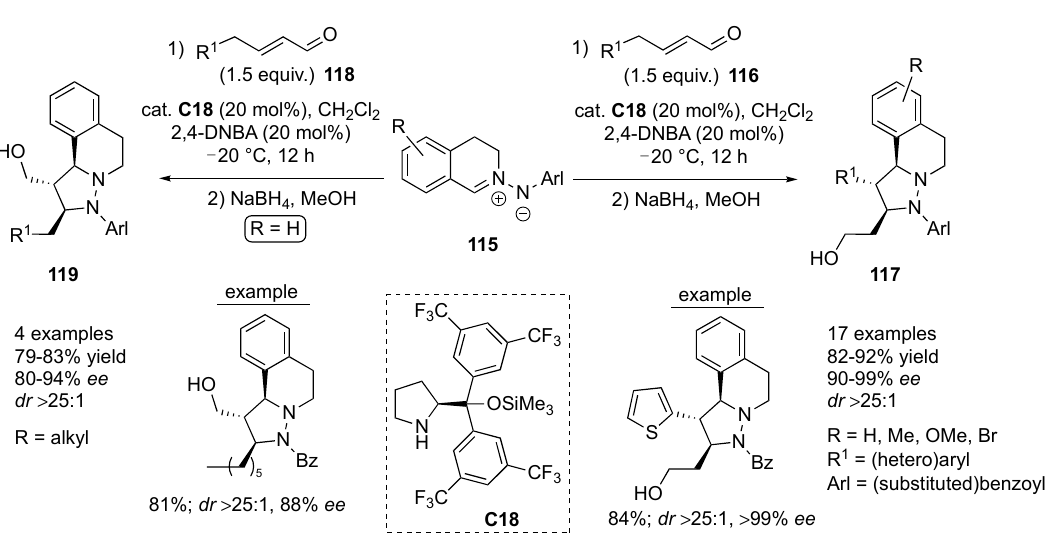
Scheme 35. Inverse electron demand cycloaddition between C , N -cyclic azomethine imines